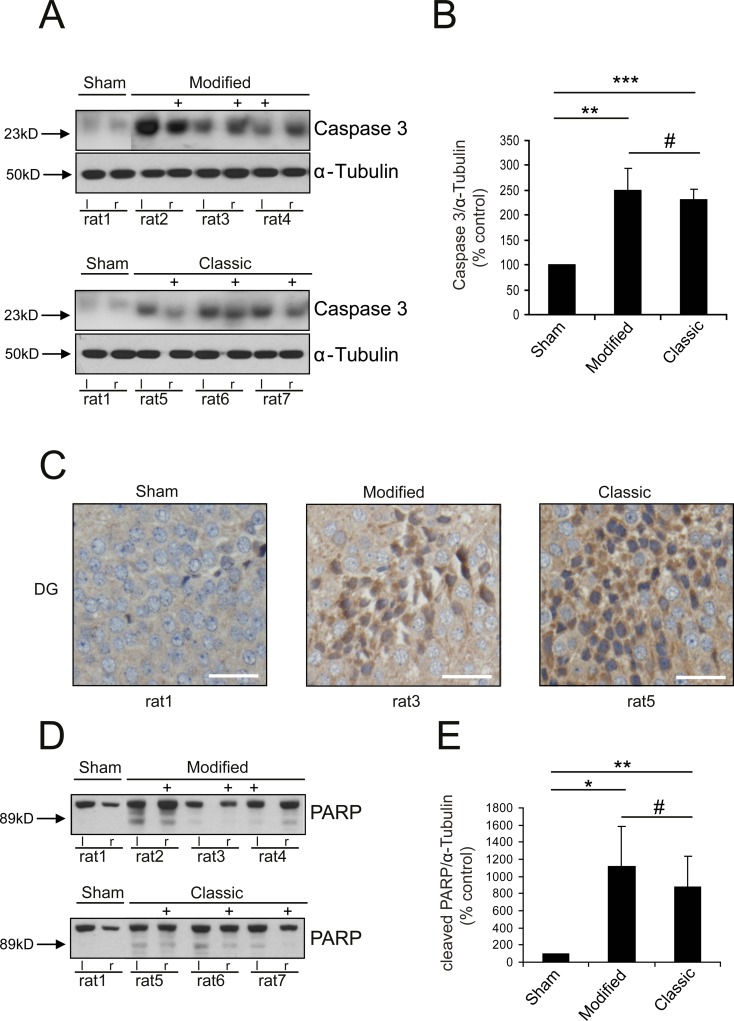
Induction of apoptotic signaling.Western Blots show an increase of caspase 3 expression (A) and PARP cleavage (D) in SAH animals (Location of ICP-probe is hallmarked (+)). Immunohistochemical staining for caspase 3 (C) confirms these results (right lower corner: bar indicates 20 μm). Semiquantitative analysis of protein expression demonstrates significant increase of caspase 3 (B) and PARP cleavage (E) in SAH animals (independent from technique). (*** p<0.001; ** p<0.01; * p<0.05; # p>0.05)